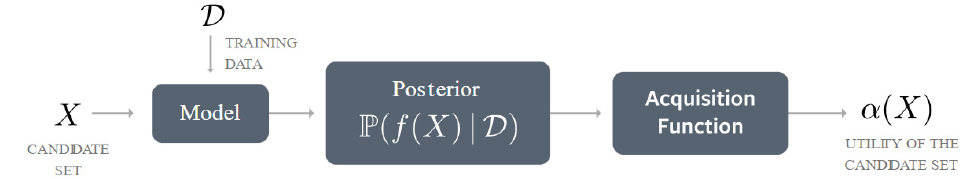
Figure 2. The general scheme of a BO framework.